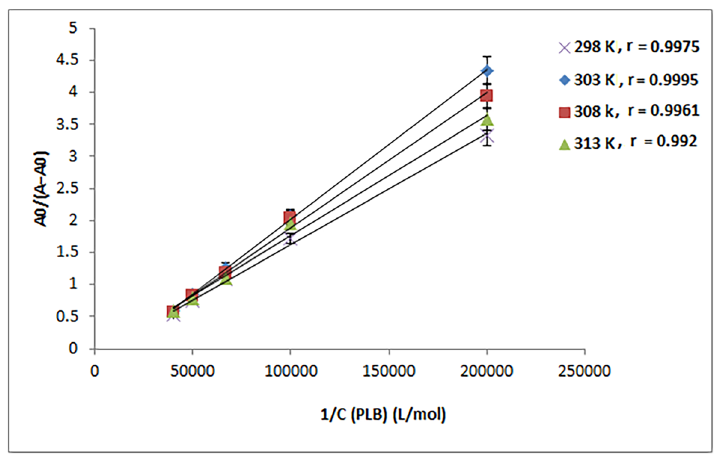
Figure 6. Plot of A 0 /( A − A 0 ) versus 1/ C PLB at different temperature settings ( C DNA = 8.25 × 10 −5 M), where r is the correlation coefficient.